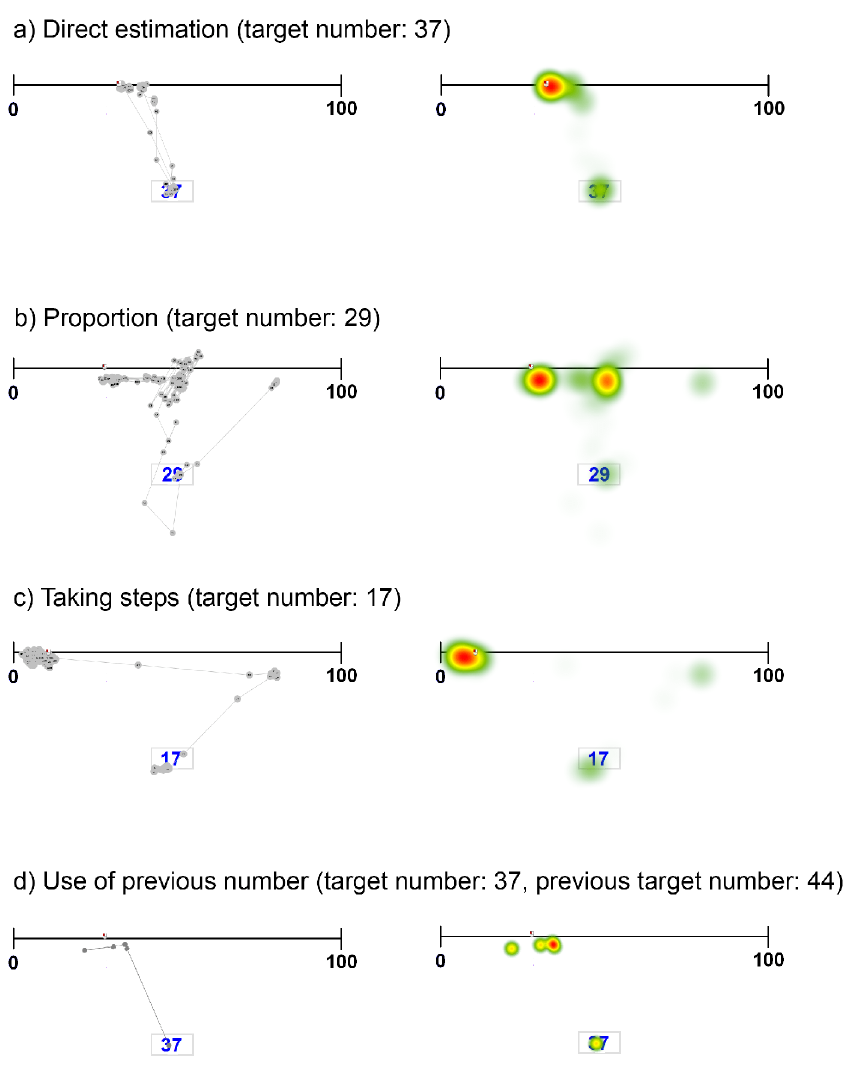
Figure 6. Representative examples of strategies used during the bounded NLT. On the left, gaze patterns are displayed, in which dots represent eye fixations and lines represent saccades (eye movements). On the right, heat maps are displayed, in which the color indicates the duration of fixations at a specific location. Green indicates short fixations, yellow indicates fixations of medium duration, and red indicates long